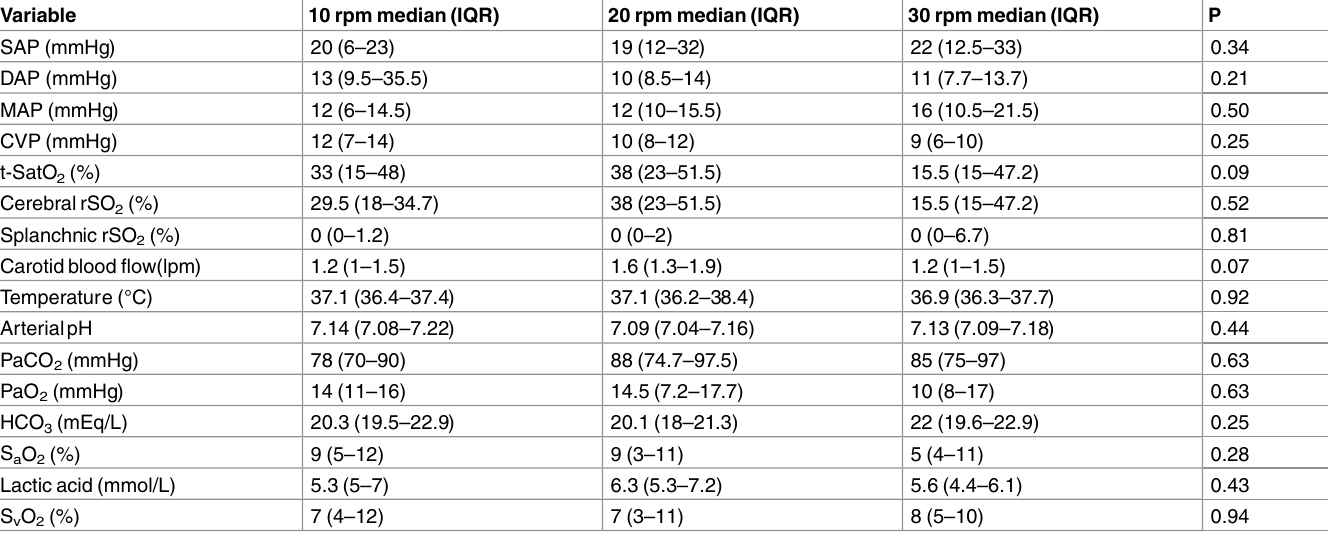
Table 1. Comparison between main variablesat baseline(10 minutesafterremove pigletsfrom ventilator).